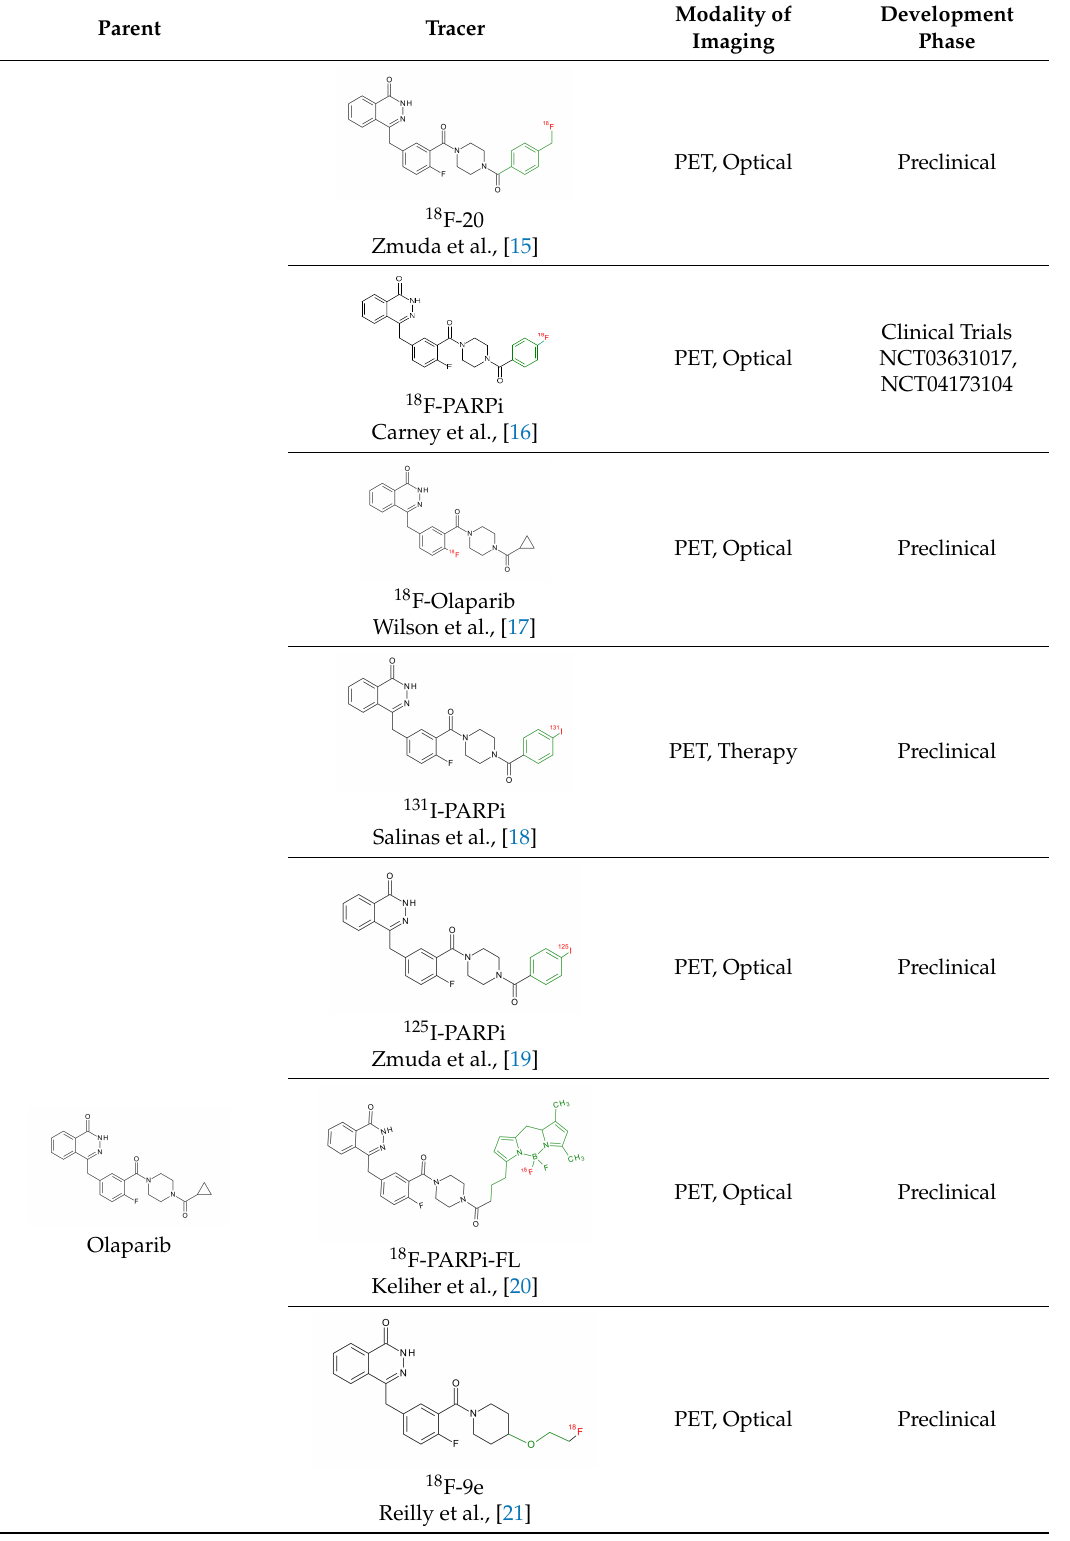
Table 1. Summary of the PARP tracers, their respective precursors, modality of imaging, and their current stage of development. Chemical structures of parent PARP inhibitors and their derivative radiotracers show structural modifications (green) and radionuclides (red). Modality of Imaging shows their PET (Positron Emission tomography)/SPECT (Single photon emission computed tomography) tracer capability.